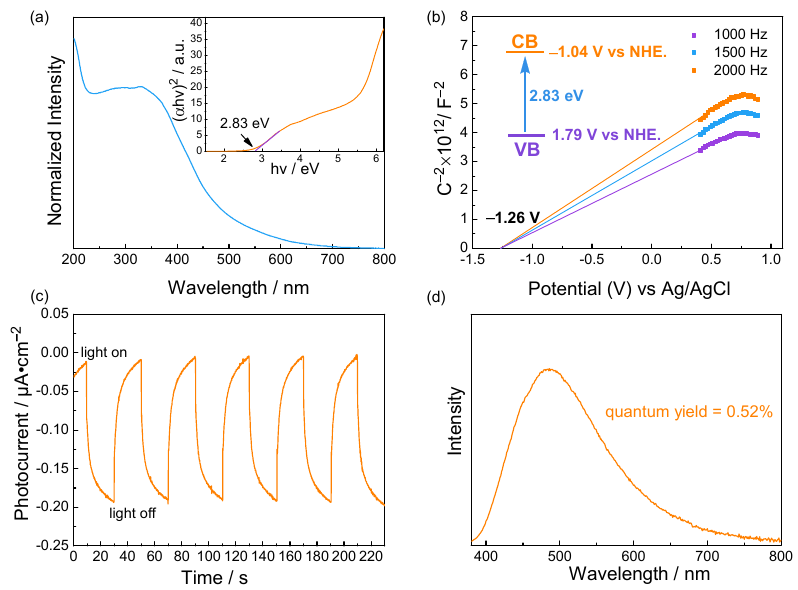
( a ) UV–Vis diffuse reflectance spectrum of Zr-MOF-P ; insets are the Tauc plots. ( b ) Mott– Schottky plots for Zr-MOF-P . ( c ) Photocurrent responses of Zr-MOF-P . ( d ) Fluorescence spectrum and quantum yield of Zr-MOF-P , λ ex = 320 nm.